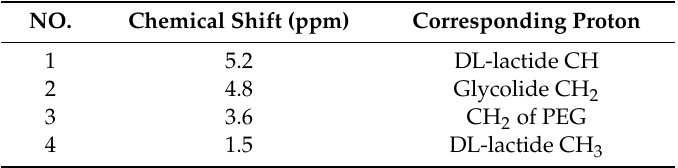
Table 1. The 1 H-NMR spectrum data analysis of the poly(lactide co-glycolide acid) and polyethylene glycol triblock copolymer